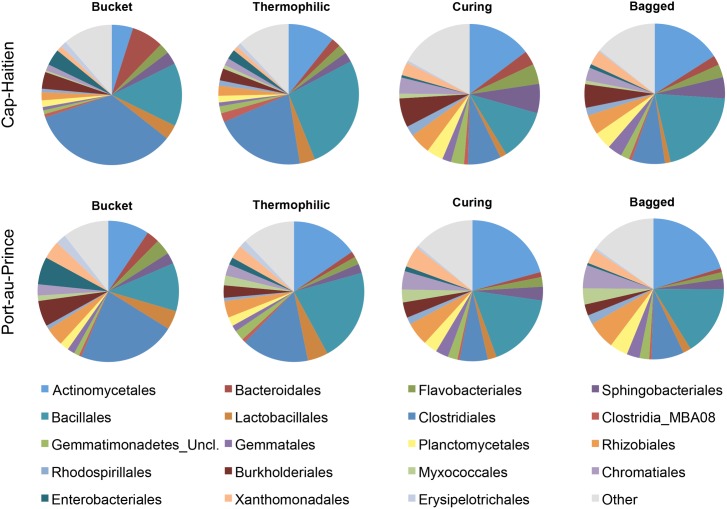
Pie charts show a summary of bacterial orders containing OTU that changed the most in relative abundance (probe intensity scores) through the thermophilic composting process.OTU for each location were included if they were within the top 100 OTU changing the most (for all pairwise comparisons within a location) and/or had at least a 10-fold change in average abundance across compost stages within each location. OTU within the orders could differ by location. Average intensity values were calculated for each OTU and percent contributions were summed at the order level for each stage and location. Named orders are those contributing at least 2% at any compost stage in either location. Following pie charts clockwise, names are listed in the legend from left to right.